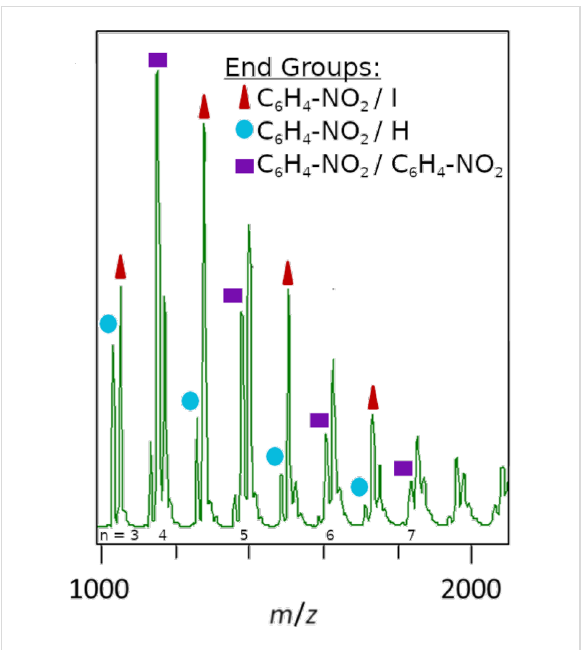
various incorporations of nitrobenzene into the polymer chains. The 2-nitrobenzoic acid used to form a silver carboxylate in the reaction system is the origin of the nitrophenyl group. Three different types of chains are represented, corresponding to in- corporation of I/nitrophenyl, H/nitrophenyl, and two nitro- phenyl end groups.